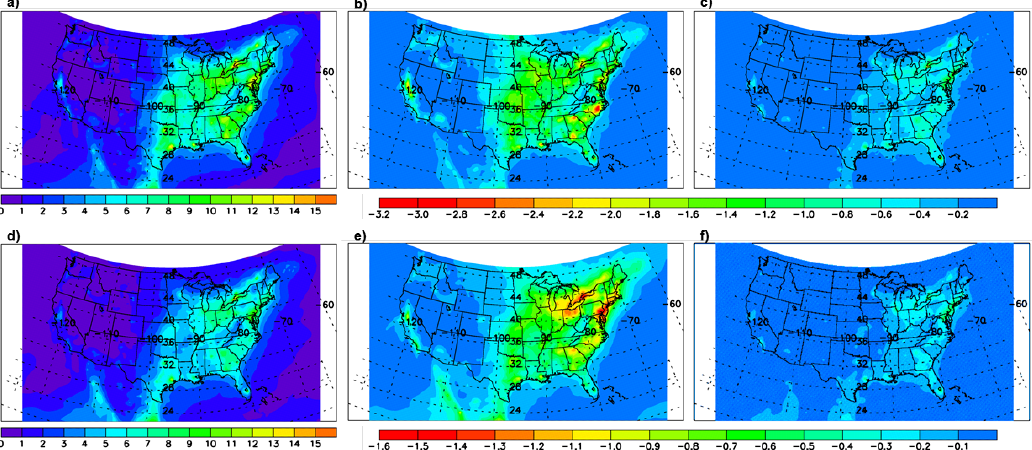
Figure 13. February 2050 average PM 2 . 5 concentrations (µgm − 3 ) simulated by CMAQ for the A1FI (top) and B1 scenarios (bottom). Each row contains the BL scenarios (left: a and d ), differences (µgm − 3 ) between the BL and H 2 -FC scenarios (center: b and e ), and differences (µgm − 3 ) between the BL and H 2 -ICE scenarios (right: c and f ). Data are from the lowest model level ( ∼ 100 m). Note that the scales are different among panels.